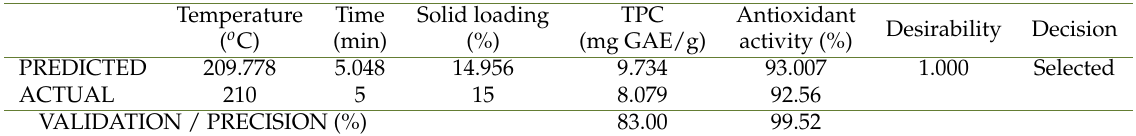
Table 3. Validation result of predicted and actual